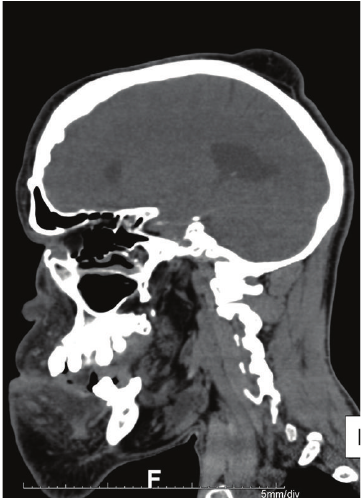
Figure 14: Sagital CT scan showing soft tissue swelling in right high parietal